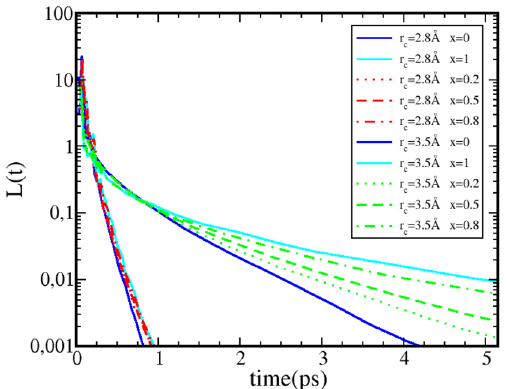
Figure 7. Cutoff and concentration dependence of the H-bond life time distributions L ( t ) for aqueous ethanol 2.8˚ A 3.5˚ A mixtures. Lines for cutoff r c = in red, and lines for cutoff r c = in green. Line for pure water in blue, and pure ethanol in cyan. Lines for ethanol concentration x=0.2 in dotted lines, for x = 0.5 in dashed lines and for x = 0.8 in dash-dotted